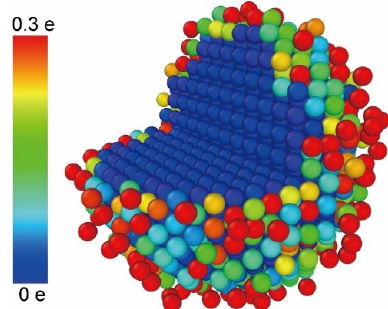
Figure 8. Snapshot of Fe nanoparticle colored by multiple of electron charge at 1 ns.